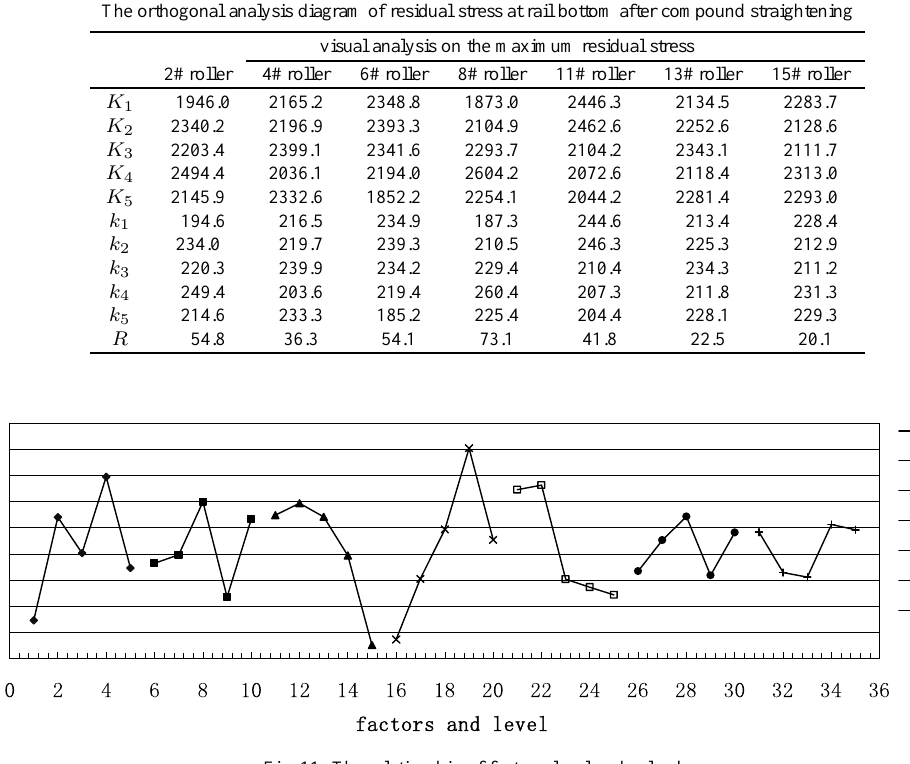
Fig. 11. The relationship of factors, level and value